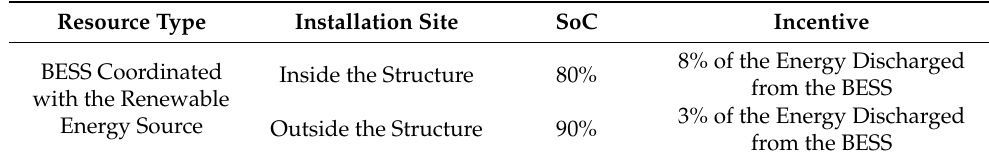
Table 3. Reliability constraints amended for the coordinated